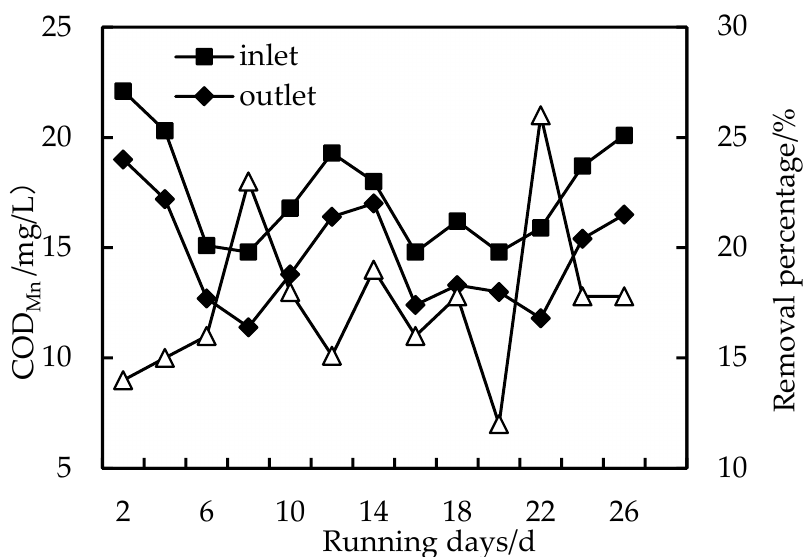
Figure 3. Removal of COD Mn with HUM.